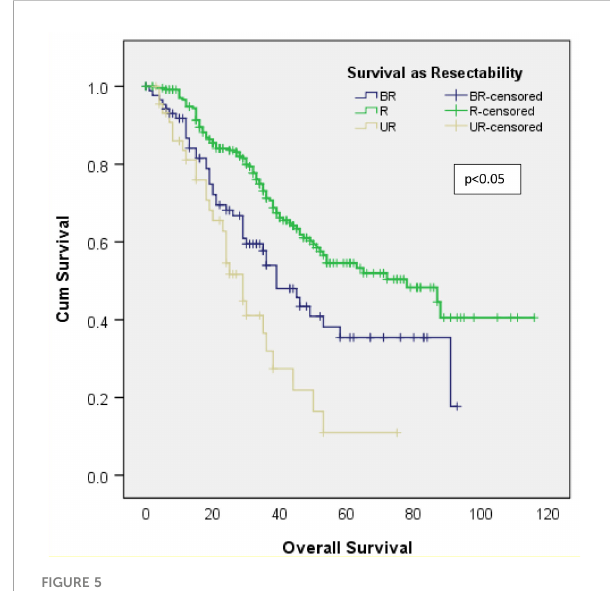
FIGURE 5 Survival as per resectability. R, resectable; BR, borderline resectable; UR, unresectable.